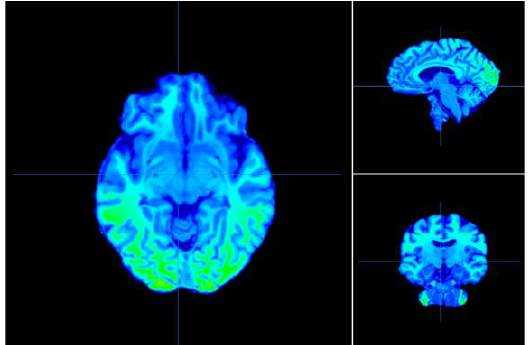
Figure 3. Resting state TMS brain scan image [287].